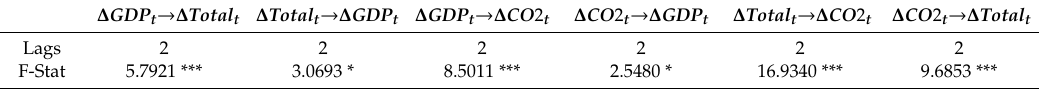
Table 7. Bivariate Linear Granger Causality